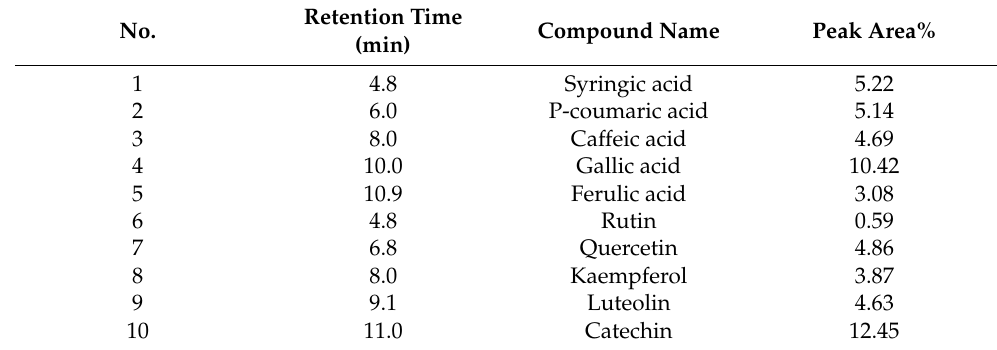
Table 7. Phenolic acids and flavonoid compositions of methanolic extract of Solenostemma argel